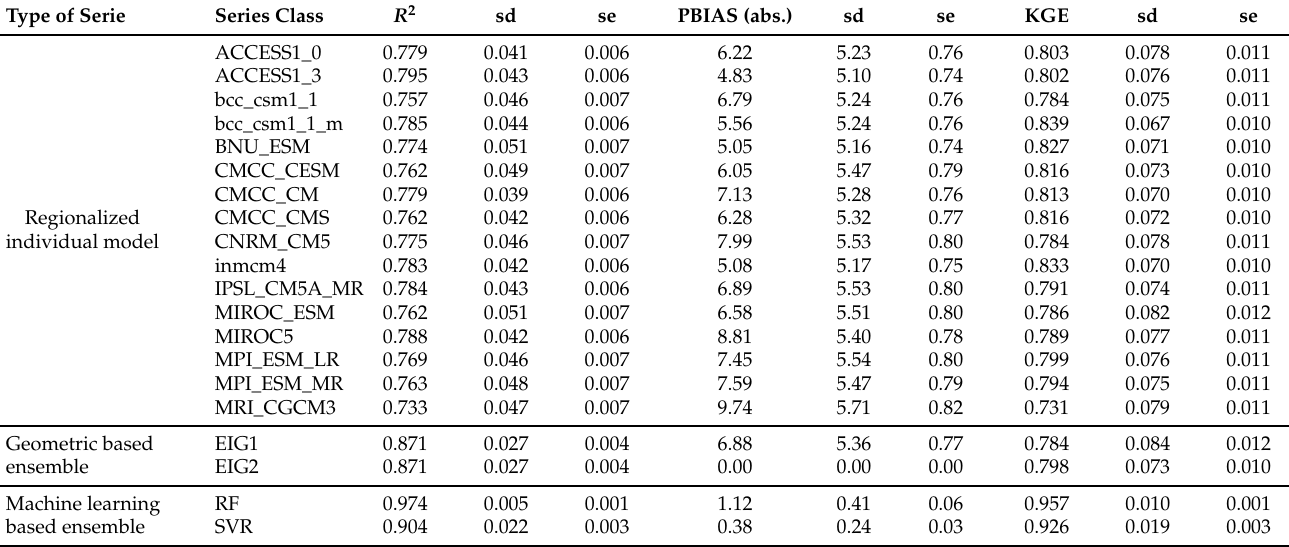
Table A1. Goodness of fit statistics in calibration for the different series. N = 1296 observations ( n k = 48 weather stations by class). Type of Serie Series Class